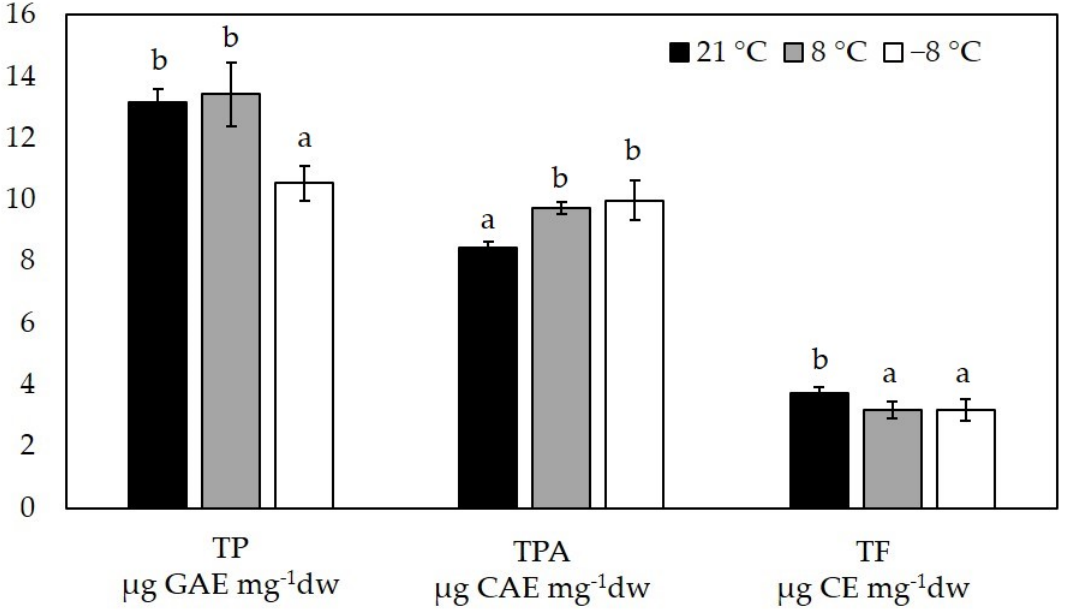
Figure 3. Content of total polyphenols (TP), total phenolic acids (TPA) and total flavonoids (TF) in flat leaf kale sprouts ( B. oleracea var. acephala ) affected by different temperatures. Value marked with different letters are significantly different at p < 0.05.